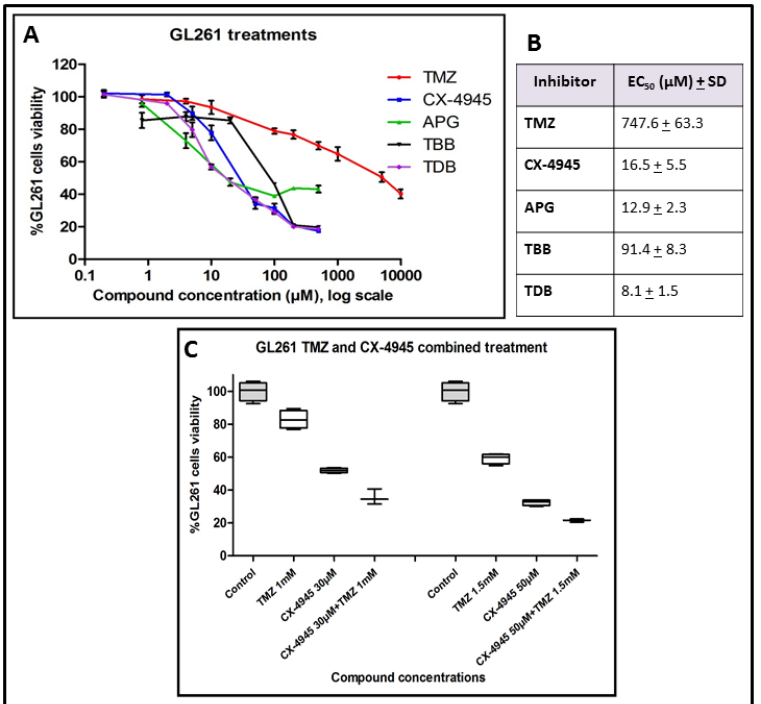
Figure 1. GL261 cells viability after treatment; ( A ) GL261 cells viability (%) “XTT assay” after 72 h